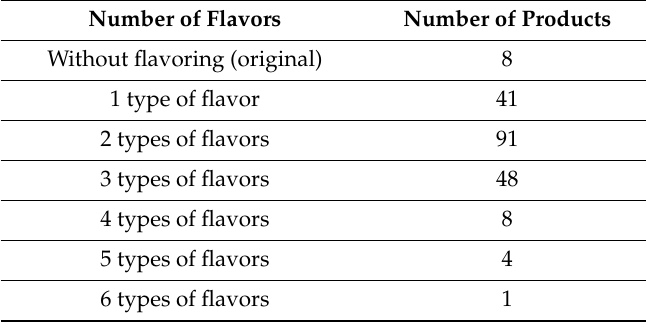
Table 6. Number of flavorings of commercial kombucha produced in the U.S. ( n =